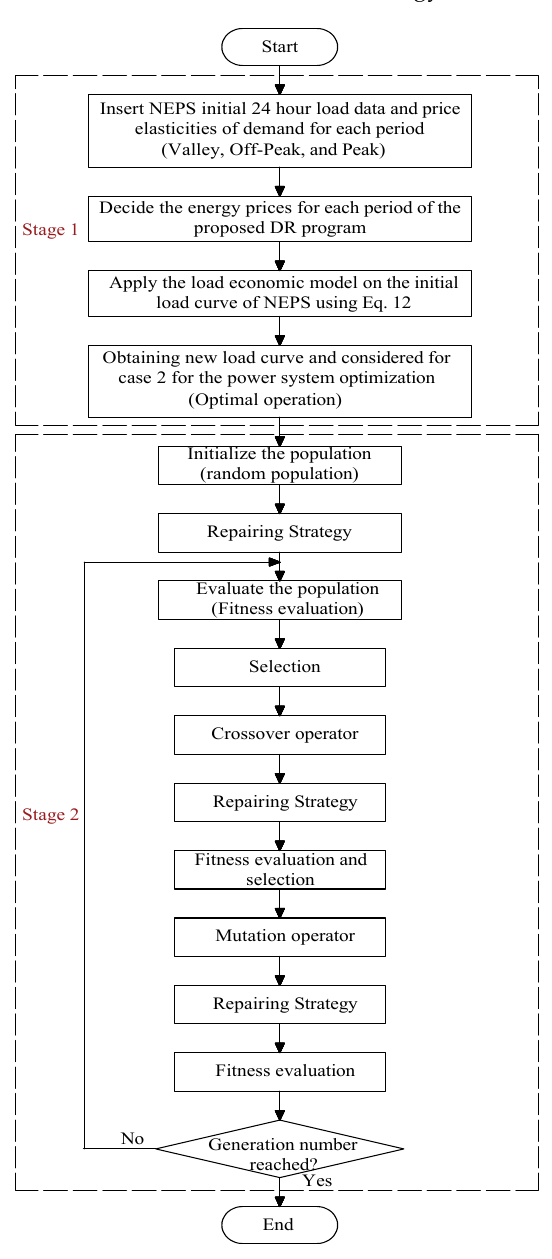
Figure 5. Flowchart of the proposed methodology used in this